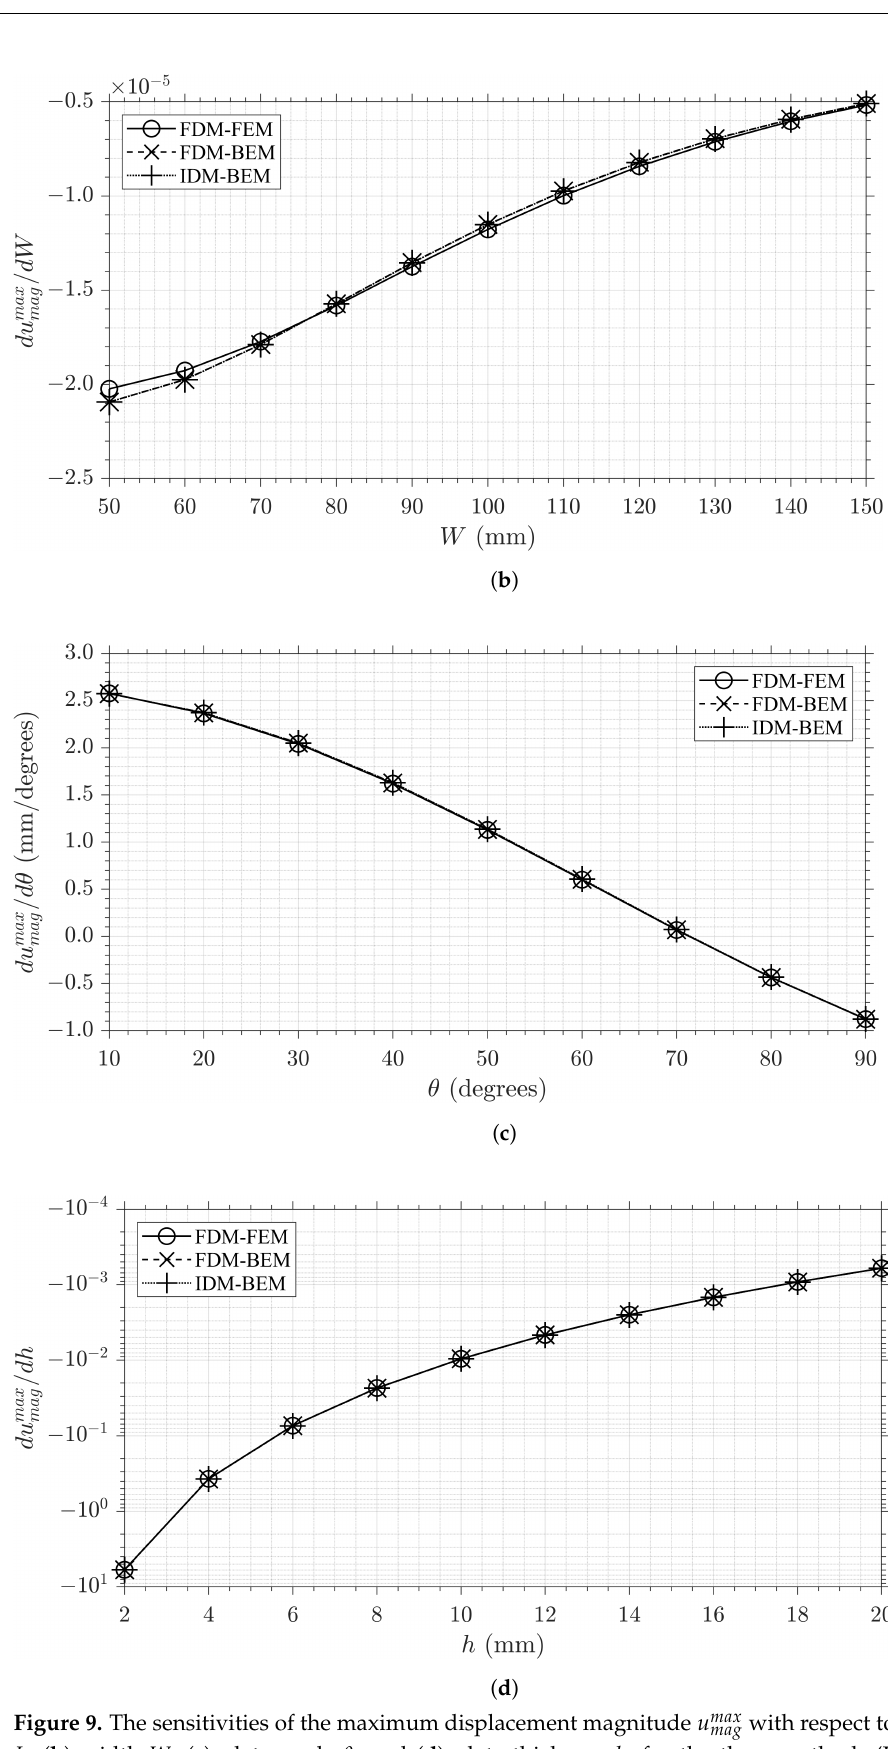
Figure 9. The sensitivities of the maximum displacement magnitude u max mag with respect to ( a ) length L , ( b ) width W , ( c ) plate angle θ , and ( d ) plate thickness h , for the three methods ‘IDM-BEM’, ‘FDM-BEM’, and